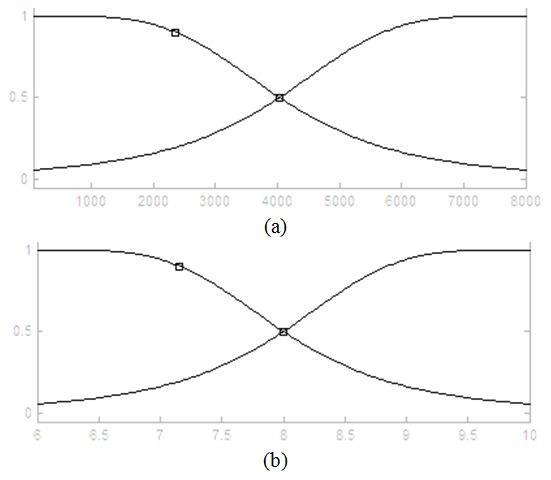
ANFIS membership functions before training procedure for (a) sound frequency and (b) wind speed fizzification.